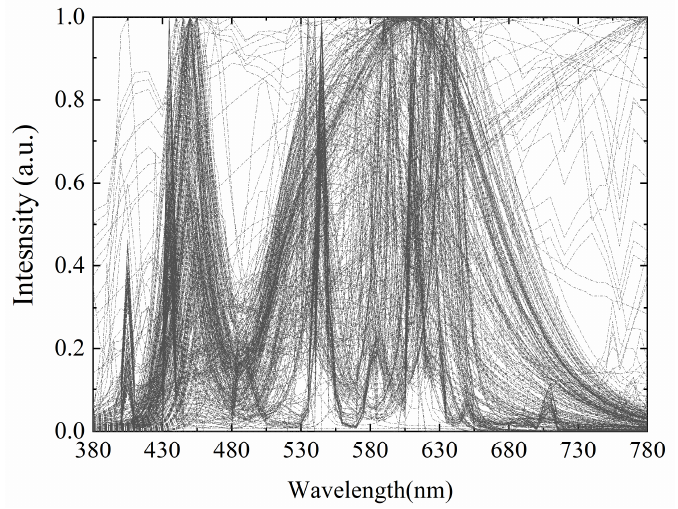
Figure 1. Spectral power distributions of light sources.